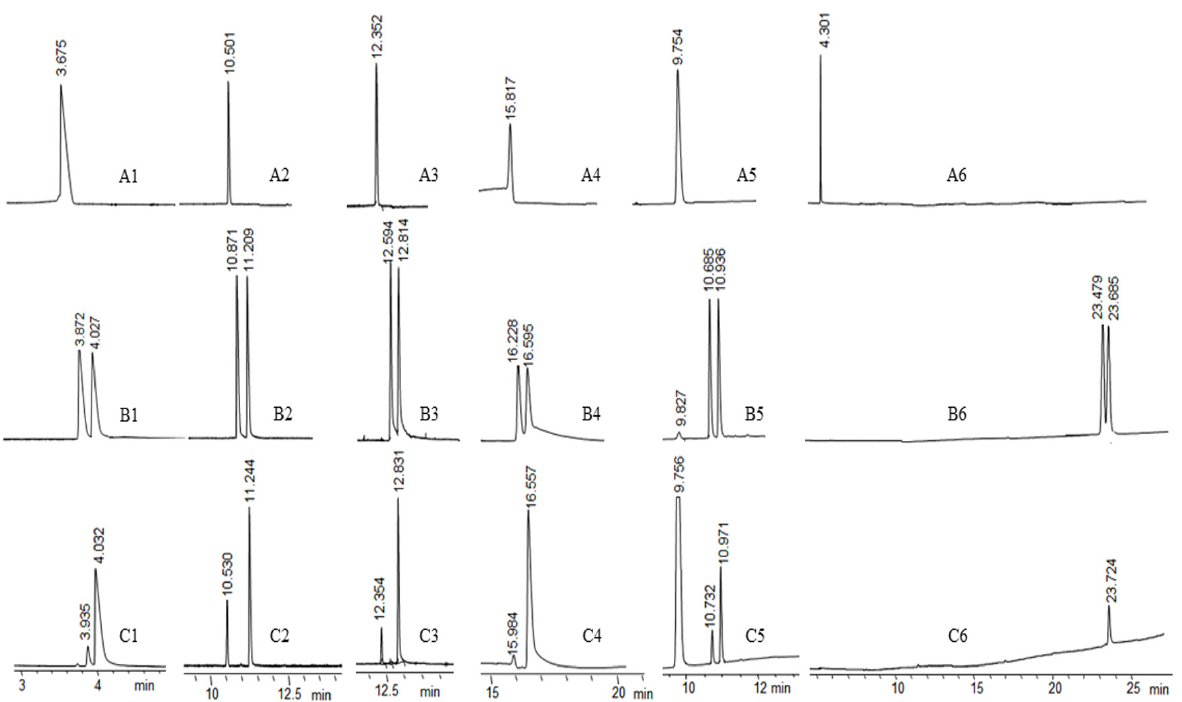
Figure 1 - Chromatograms showing the β-ketoesters and correspondent reduction products: (A1) ethyl 3-oxobutanoate; (A2) methyl 3-oxopentanoate; (A3) ethyl 3-oxopentanoate; (A4) ethyl 3-oxohexanoate; (A5) methyl 4-chloro-3-oxobutanoate, (A6) methyl 3-(4-chlorophenyl)-3-oxopropanoate; B1–B6 - racemate obtained via NaBH reduction. The retention times are indicated above each chromatogram